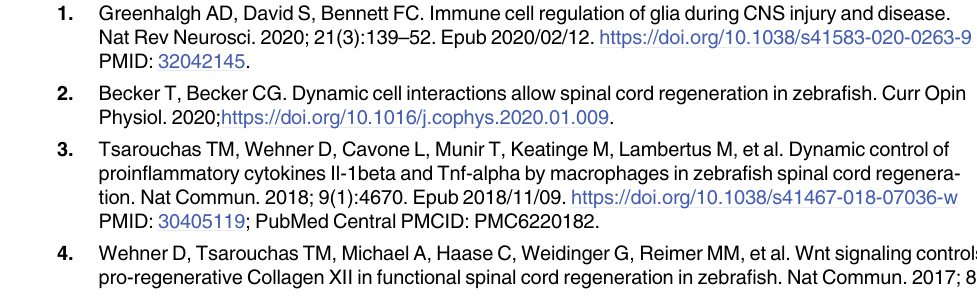
S1 Table. List of sCRNAs. This is a list all sCrRNAs used in this study and their efficiencies as determined by RFLP. S2 Table. Genes used in spinal cord injury screen. This is a list of genes that are used in the spinal cord injury in vivo screen, also containing information on expression and regulation after